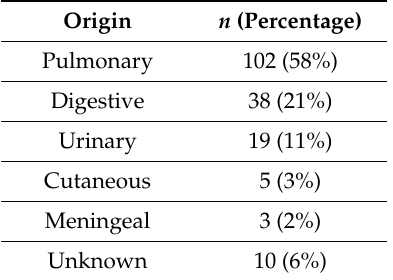
Table 2. Presumed septic shock